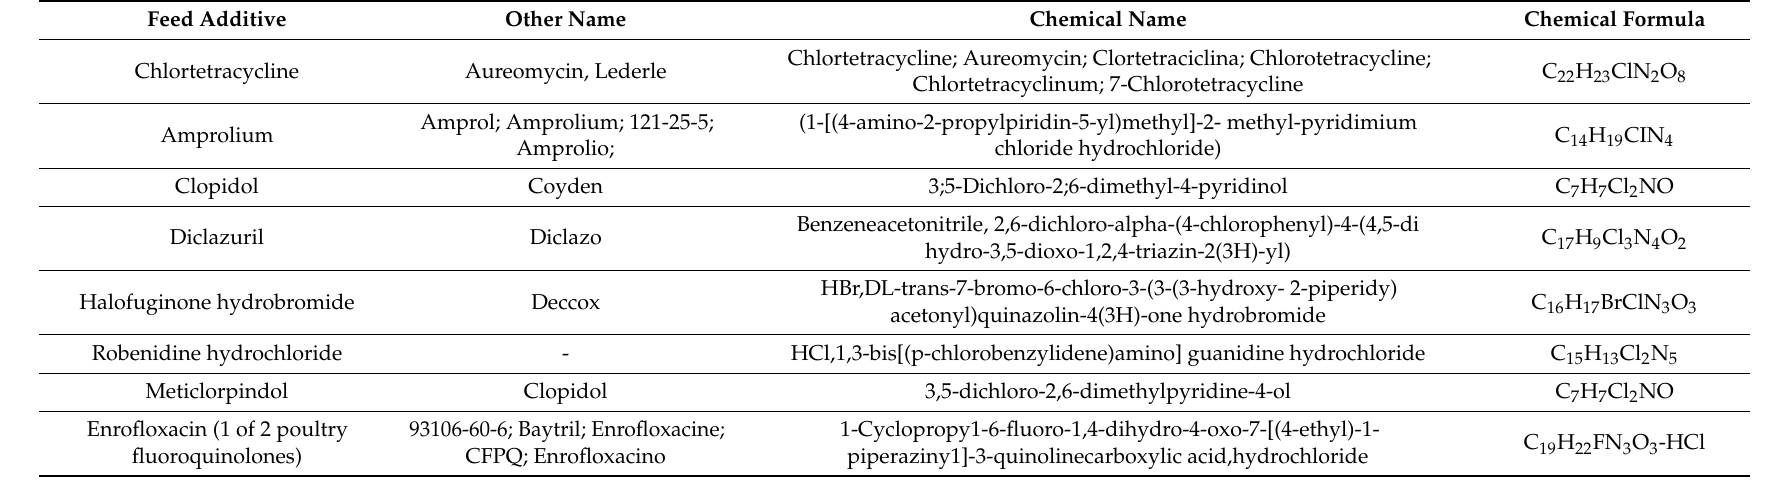
Table 7. Chlorinated antibiotic chicken feed additives as adopted from Ewall [74].